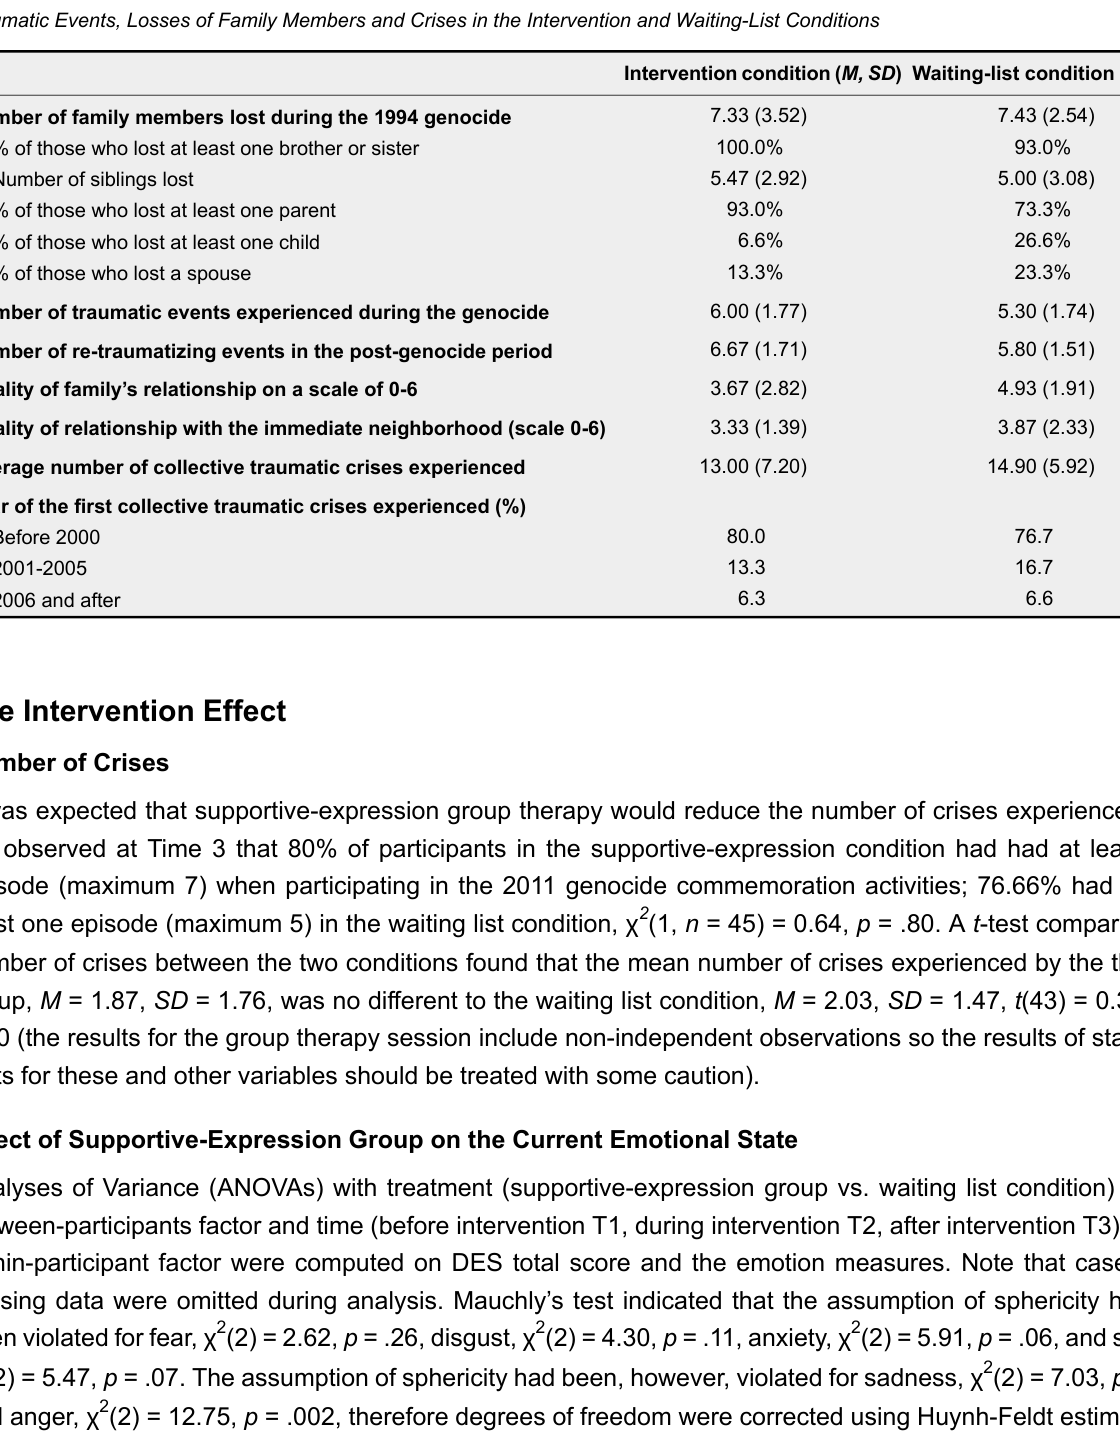
Traumatic Events, Losses of Family Members and Crises in the Intervention and Waiting-List Conditions